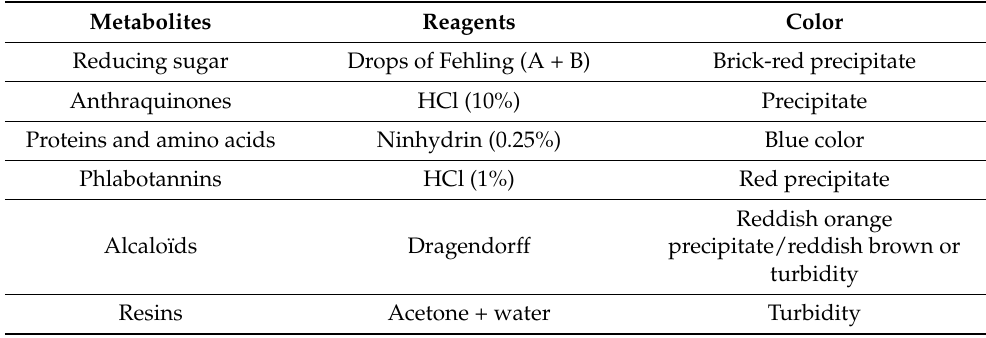
Table 1. Qualitative detection of primary and secondary metabolites of pomegranate peel